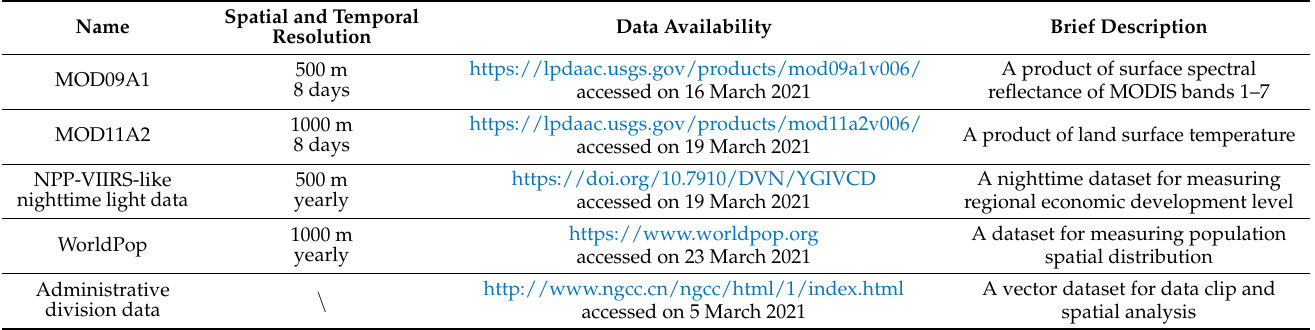
Table 1. Introduction of datasets.